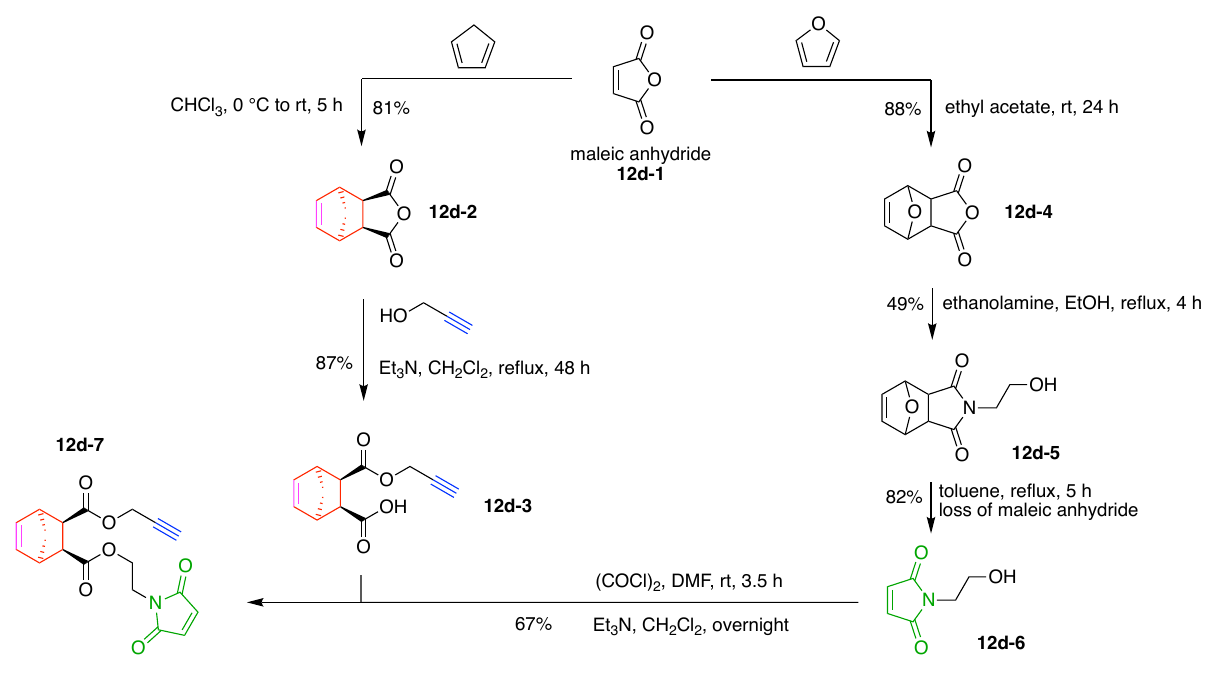
Figure 60. Synthesis of an alkynyl-maleimide hub.